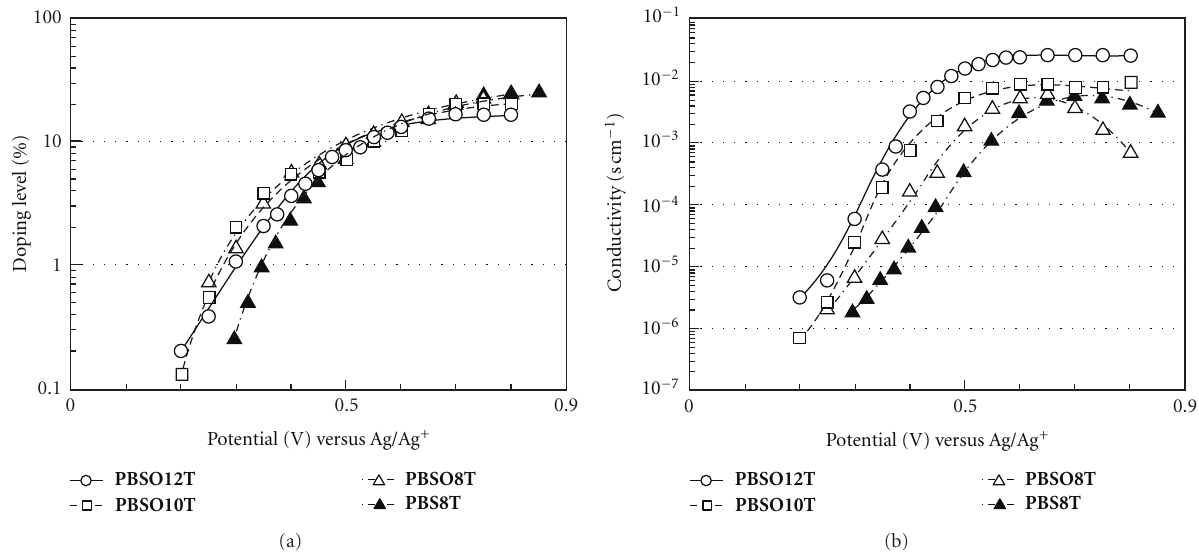
Figure 6: (a) Doping levels and (b) electrical conductivities plotted against electrode potential for (cid:2) : PBS8T , Δ : PBSO8T , (cid:3) : PBSO10T , and (cid:4) : PBSO12T films.